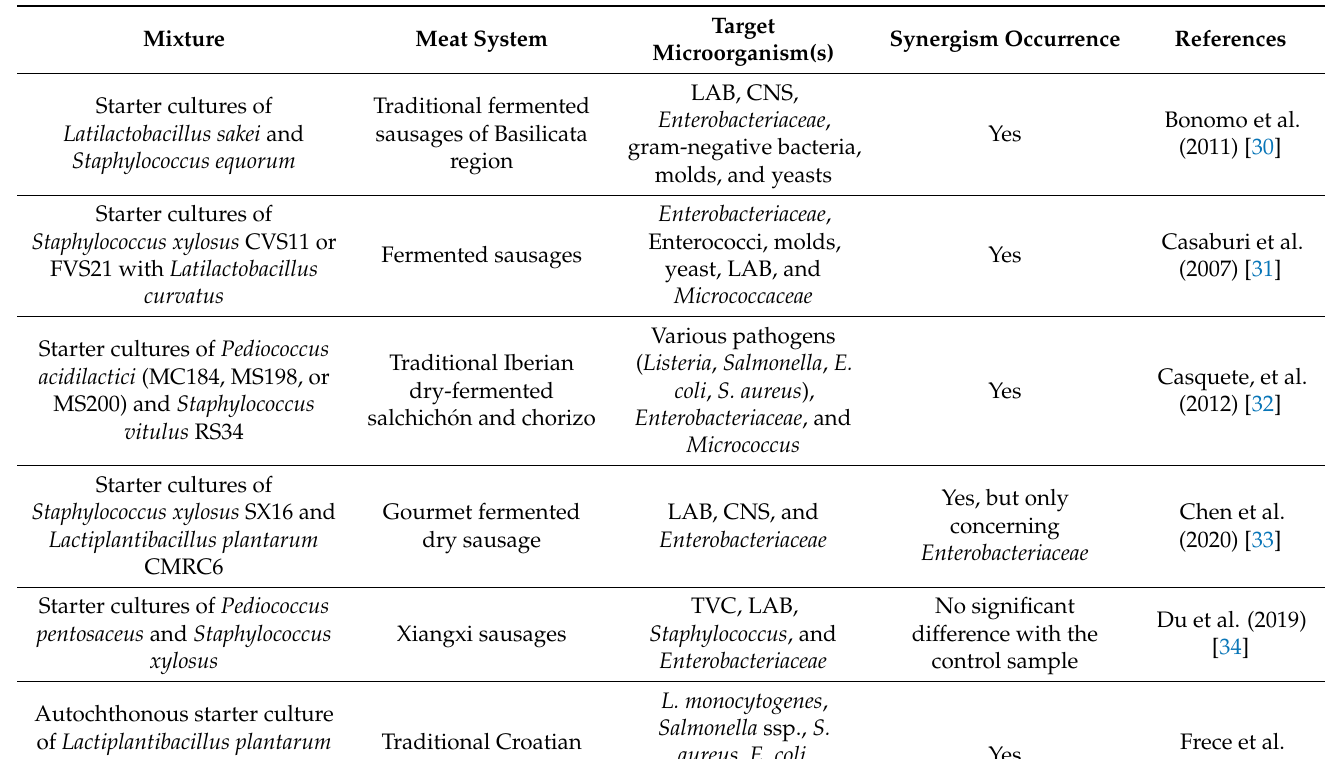
Table 1. The use of diverse combinations of starter cultures against different target